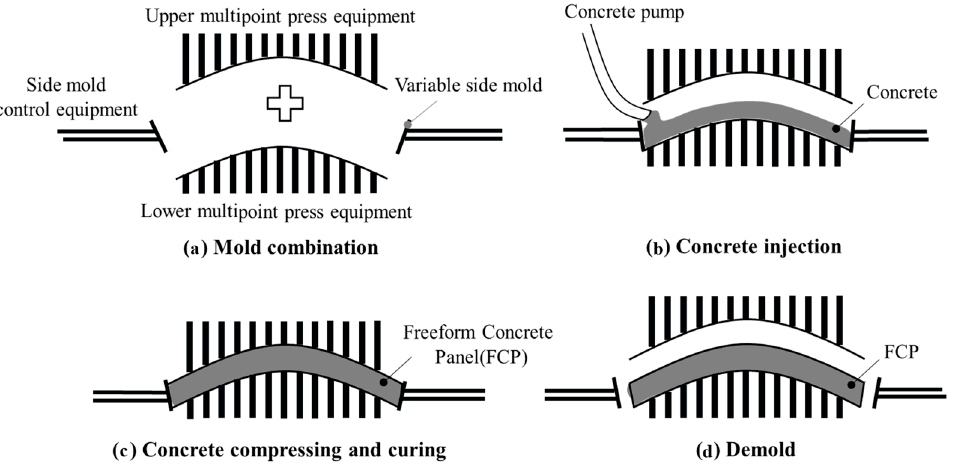
Figure 1. Freeform concrete panel production